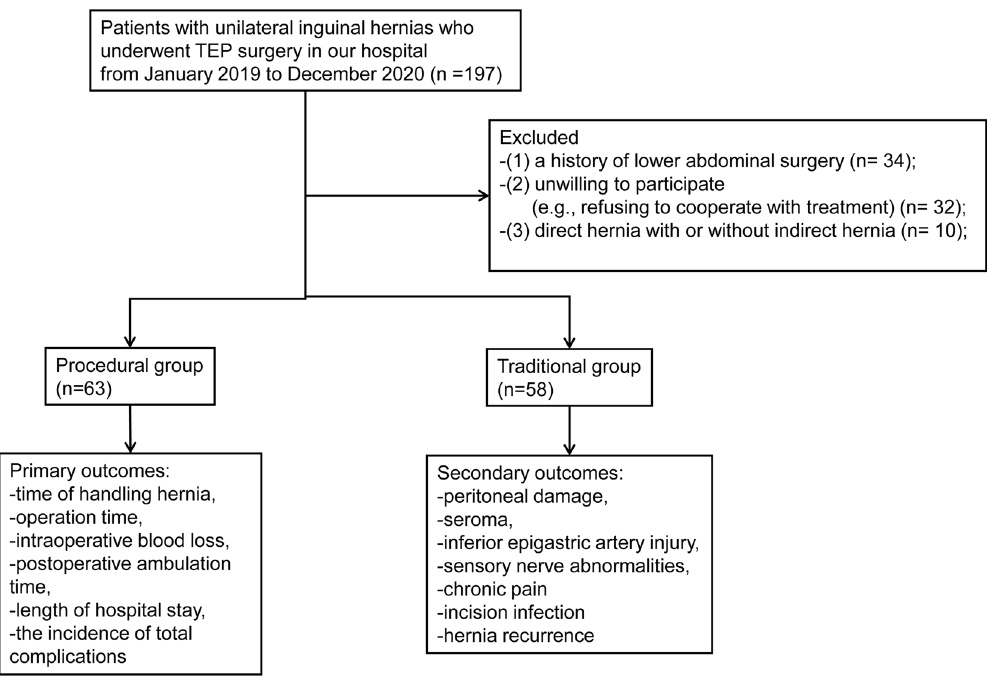
Figure 3. Flow chart of patients’